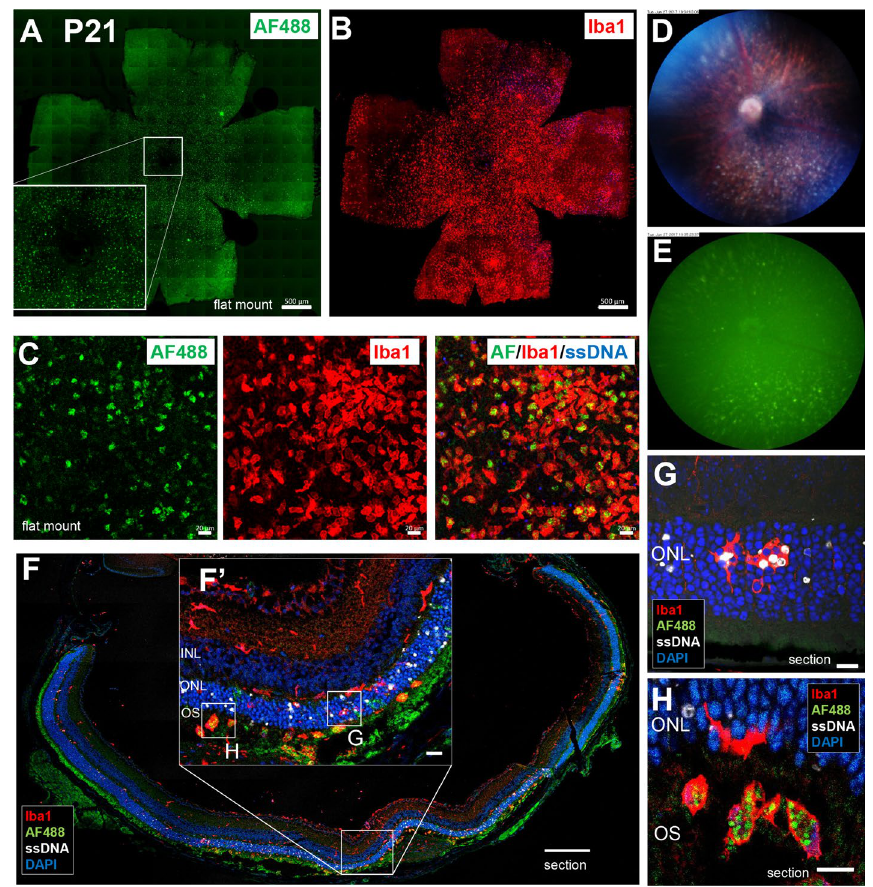
Figure 7. Histopathological findings on diffuse fundus autofluorescent spots in the retina of rd10 at P21. ( A ) Accumulation of FAF spots was observed in the ONL around the central retina of rd10 at P21. Scale bar, 500 μm. ( B ) Accumulation of Iba1 + microglia was observed in the ONL layer around the centeral retina of the same mouse. Scale bar, 500 μm. ( C ) Flat-mounted retina of rd10 at P21 showing autofluorescent spots were labeled with Iba1 and ssDNA. The autofluorescent spots coincided with Iba1 + microglia but not with ssDNA + apoptotic cells. Scale bars, 20 μm. ( D ) In the color fundus photograph, white granules accumulated under the retina were seen on P21. ( E ) In vivo FAF imaging of the same rd10 mouse. The localization of the fluorescent spots coincided with white granules in the subretina. ( F ) Retinal section of rd10 at P21 labeled with Iba1, ssDNA and DAPI. More apoptotic photoreceptors were observed in the ONL around the central retina. Scale bar, 200 μm. ( F ′ ) In retinal section near the center, Iba1 + microglia accumulated in the OS. Scale bar, 20 μm. ( G ) In the magnified image of the ONL, microglia that infiltrated into the ONL phagocytosed ssDNA positive and negative photoreceptors. Scale bar, 10 μm. ( H ) In the magnified image of the subretina, microglia in the OS stored fluorescent granules in their body. Scale bar, 10